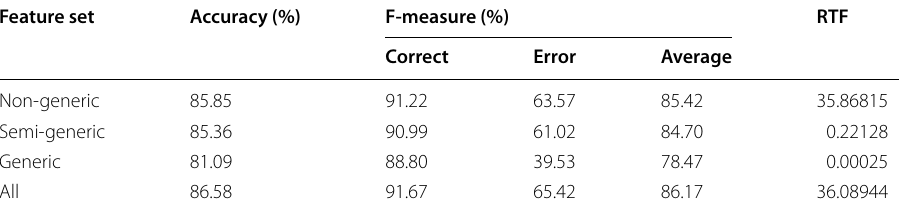
Table 5 V-RNN classification accuracies, F-measures and RTF of error detection obtained based on generic versus non-generic and semi-generic features Feature set